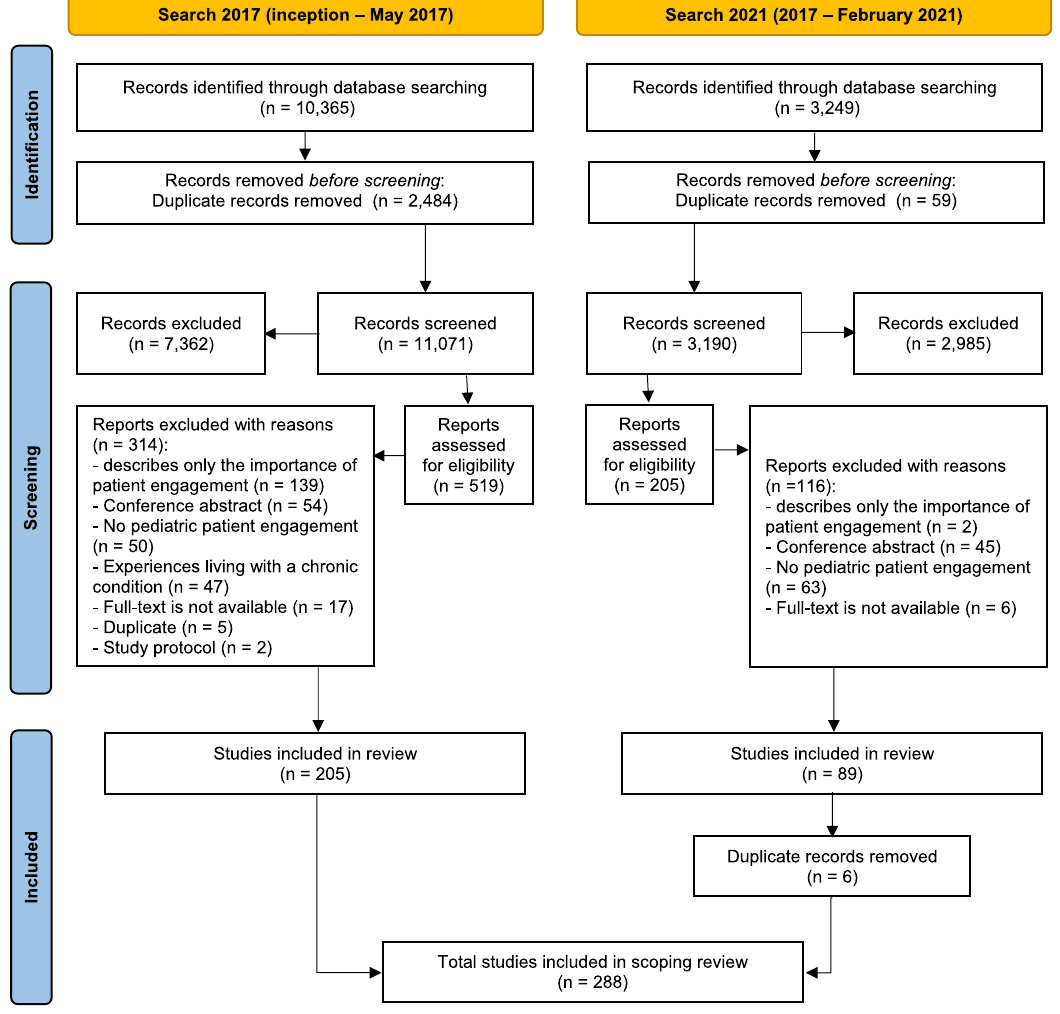
Fig. 1 Flow chart of the identification and selection process of studies